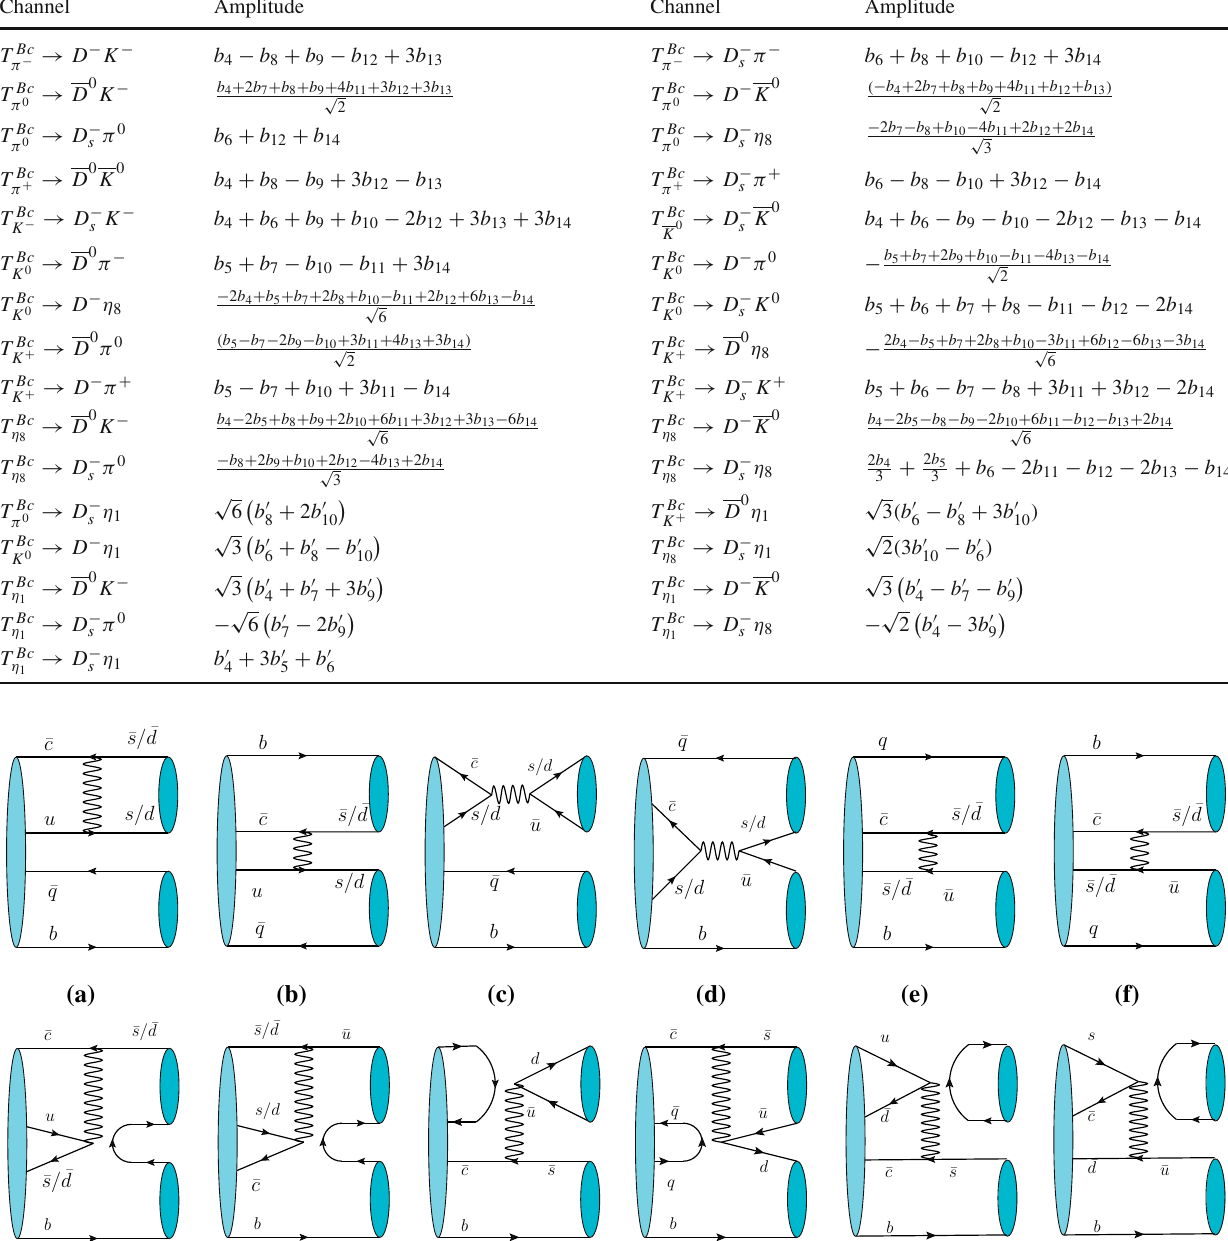
Table 7 Tetraquark T b ¯ c 8 / T b ¯ c 1 decays into anti-charmed and light mesons induced by the charmless b → s transition Channel Amplitude Channel